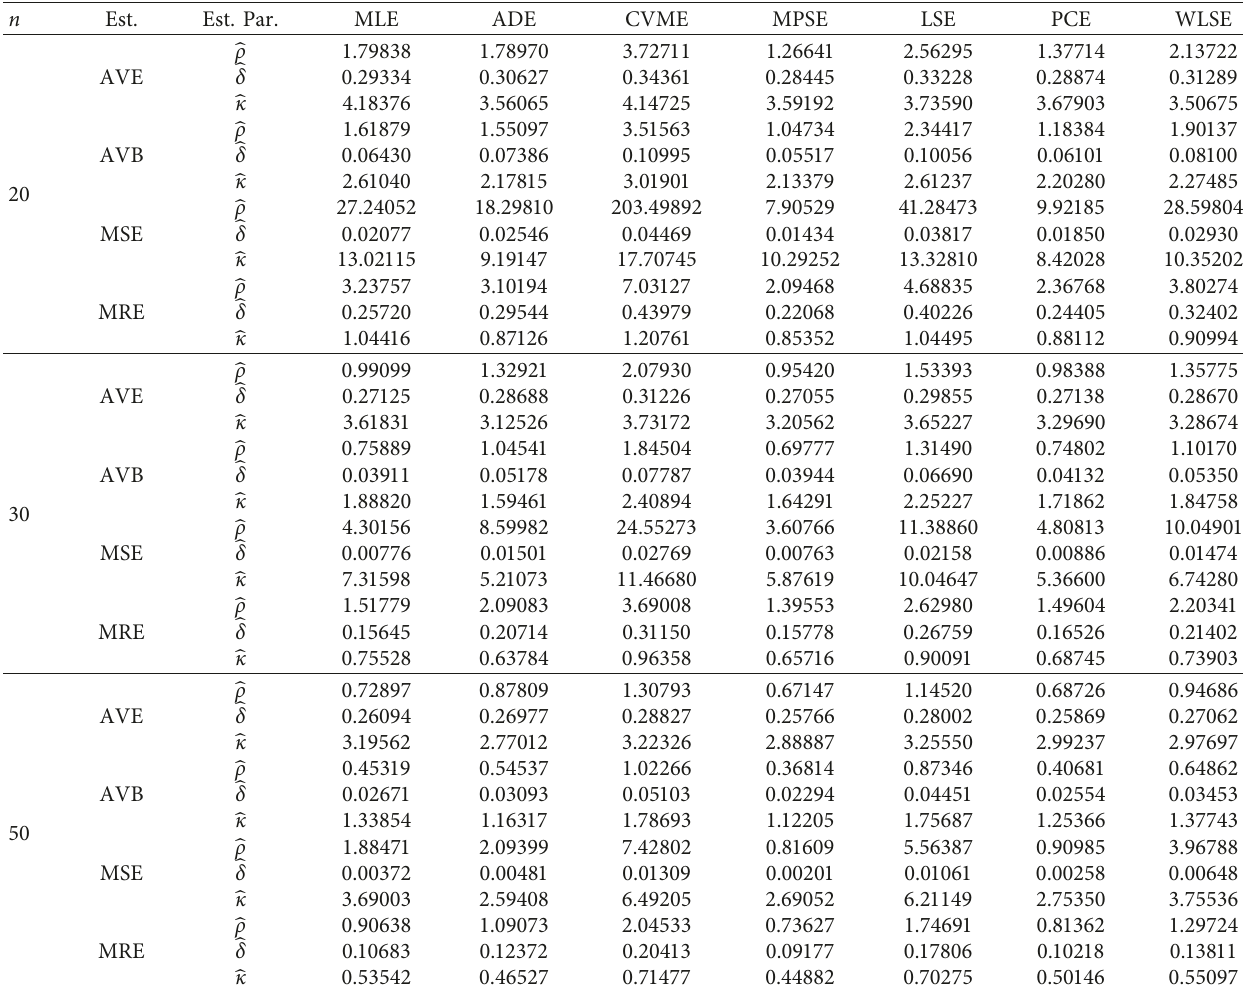
Table 2: Simulation results of the AVE, AVB, MSE, and MRE of BXLE distribution for ( ρ � 0 . 5 , δ � 0 . 25 , κ � 2 . 5 ) . n Est. Est.